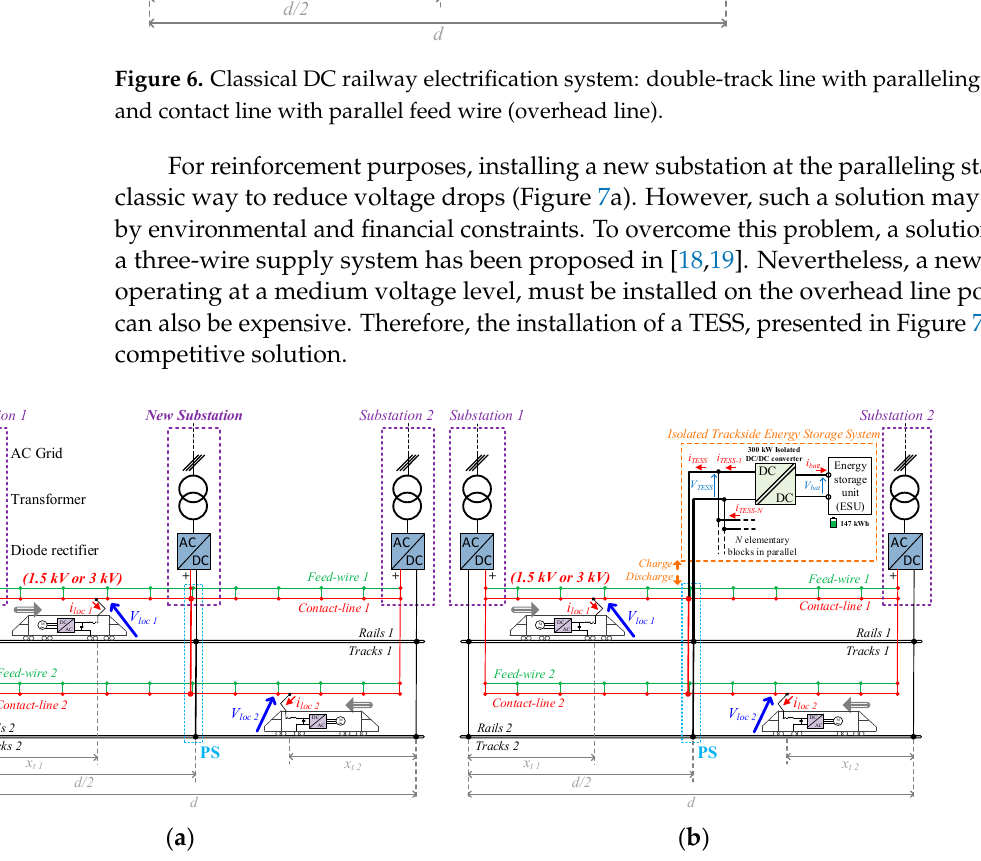
Figure 6. Classical DC railway electri fi cation system: double-track line with paralleling station (PS) and contact line with parallel feed wire (overhead line).